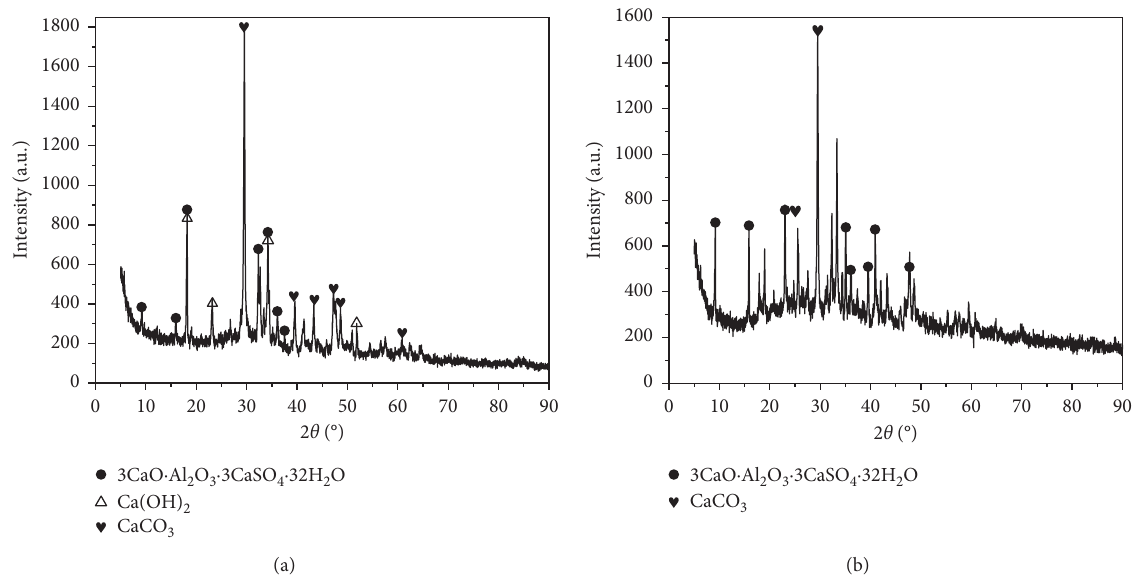
Figure 9: XRD pattern of cured foam filling material when molded for seven days. (a) OPC. (b)